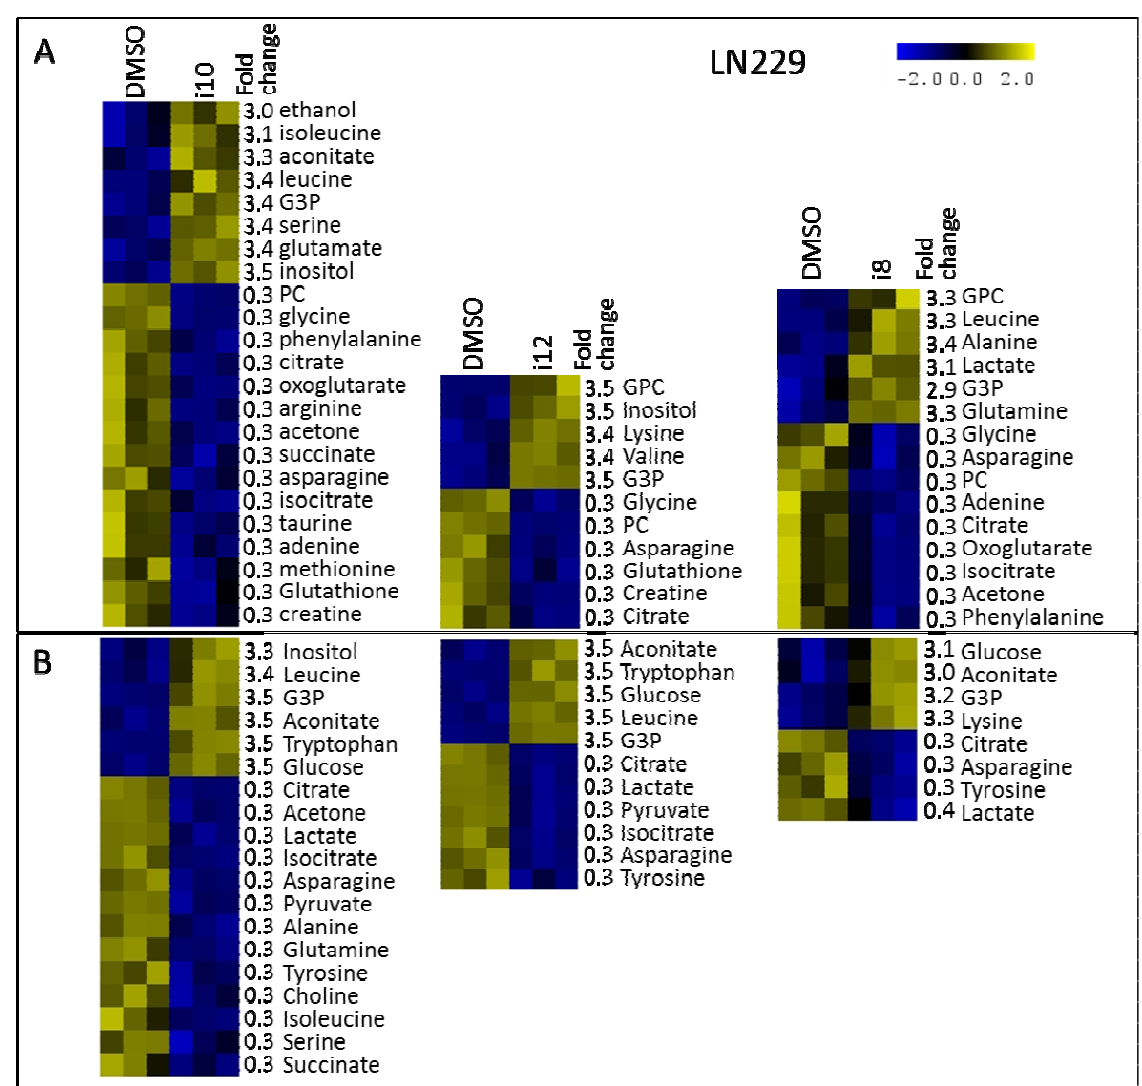
Figure 10. Major metabolic differences induced by i10, i12 and i8 treatments in intracellular ( A ) and extracellular ( B )